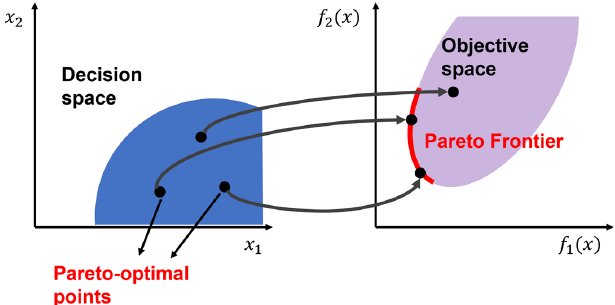
FIG. 1. Mapping decision space to objective space and Pareto optimal points to the Pareto front in